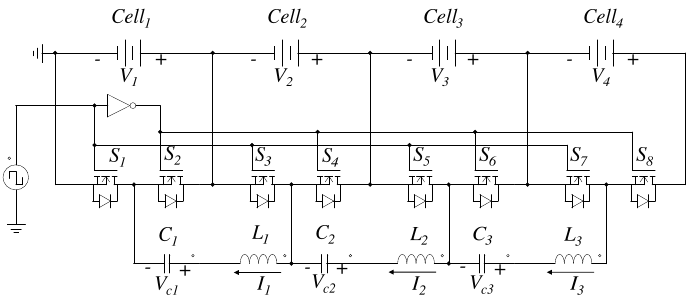
Figure 28. Switched capacitor–inductor network equalizer.